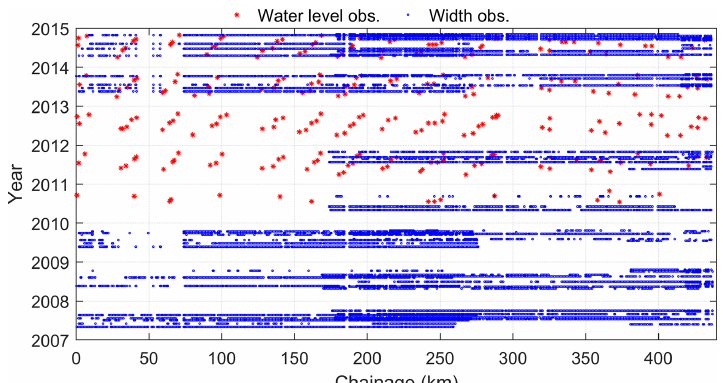
Figure B1. Temporal and spatial distribution of water levels and widths, which are used to calibrate the model. Given that the river is frozen in cold season, only data in warm seasons are used. Landsat 5/8 images with low cloud cover (visual checked in Google Earth Engine) are selected to generate river width.